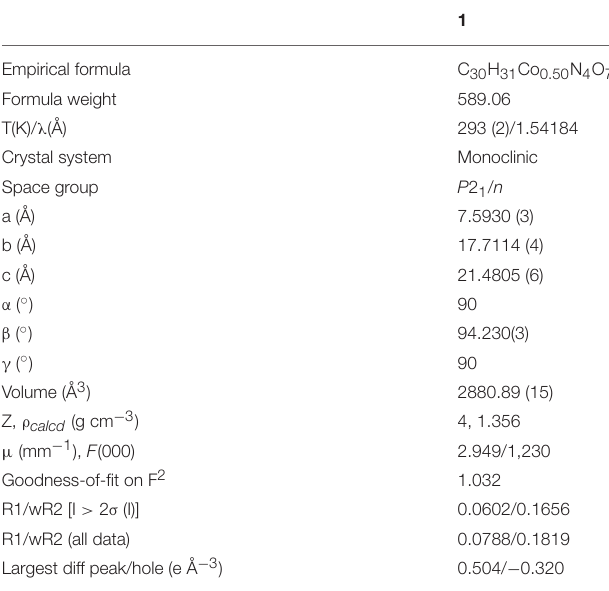
TABLE 1 | Crystal data and structure refinement parameters for compound 1